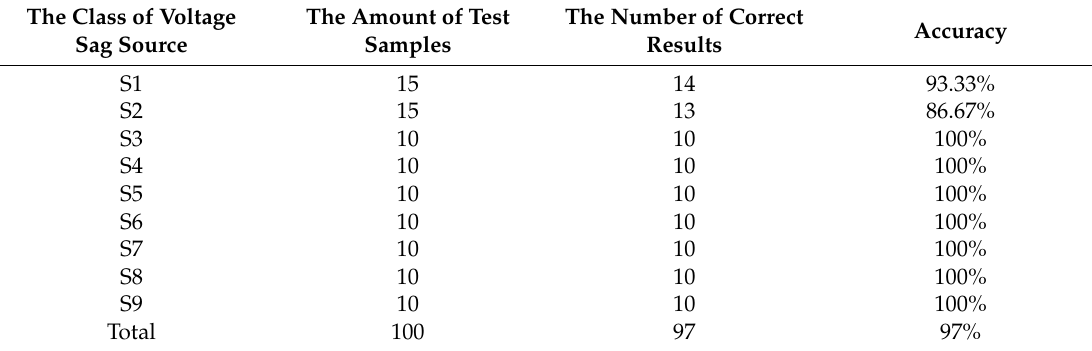
Table 4. The accuracy of voltage sag source identification method based on self-supervised CNN model.